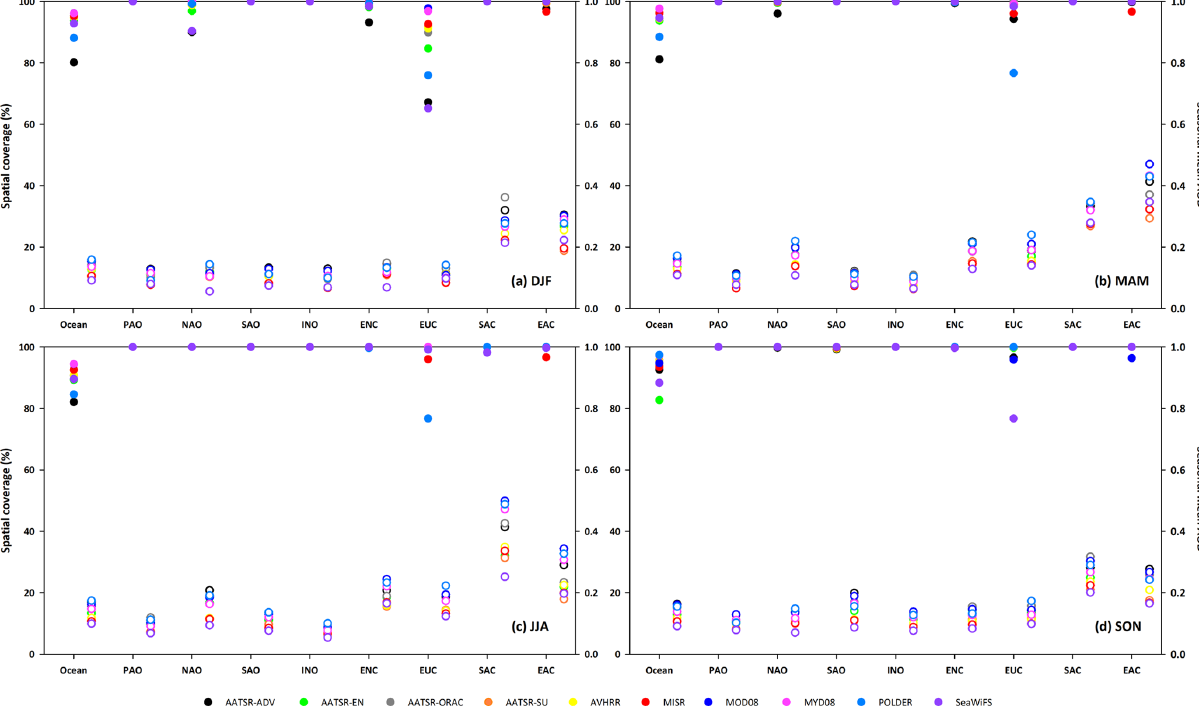
Atmos. Chem. Phys., 19, 7183–7207, 2019